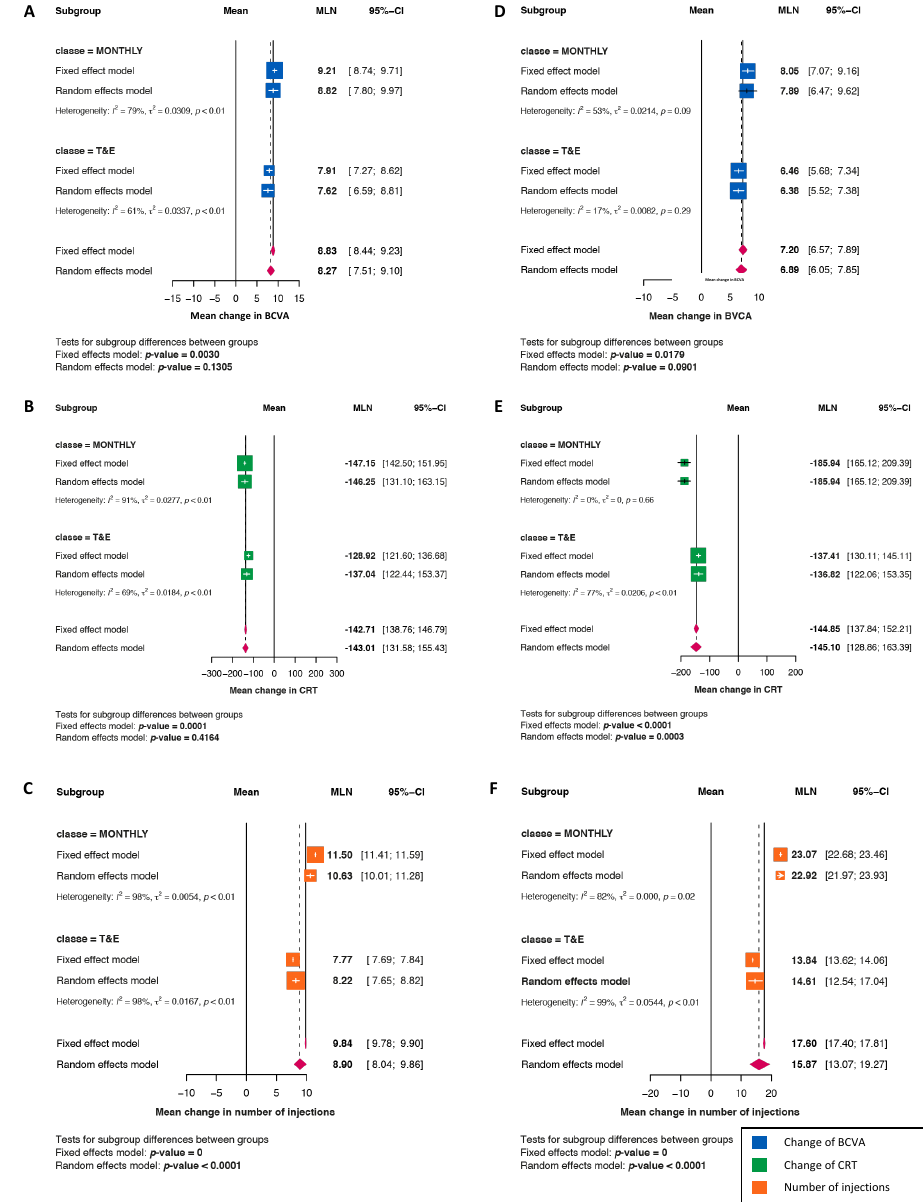
Figure 3. Treat and Extend (T&E) versus Monthly regimens. ( A – C ): Mean change at 1 year, in best corrected visual acuity (( A ), blue squares), in CRT (( B ), green squares) and in the number of injections (( C ), orange squares). ( D – F ): Mean change at 2 years, in best corrected visual acuity (( D ), blue squares), in CRT (( E ), green squares) and in the number of injections (( F ), orange